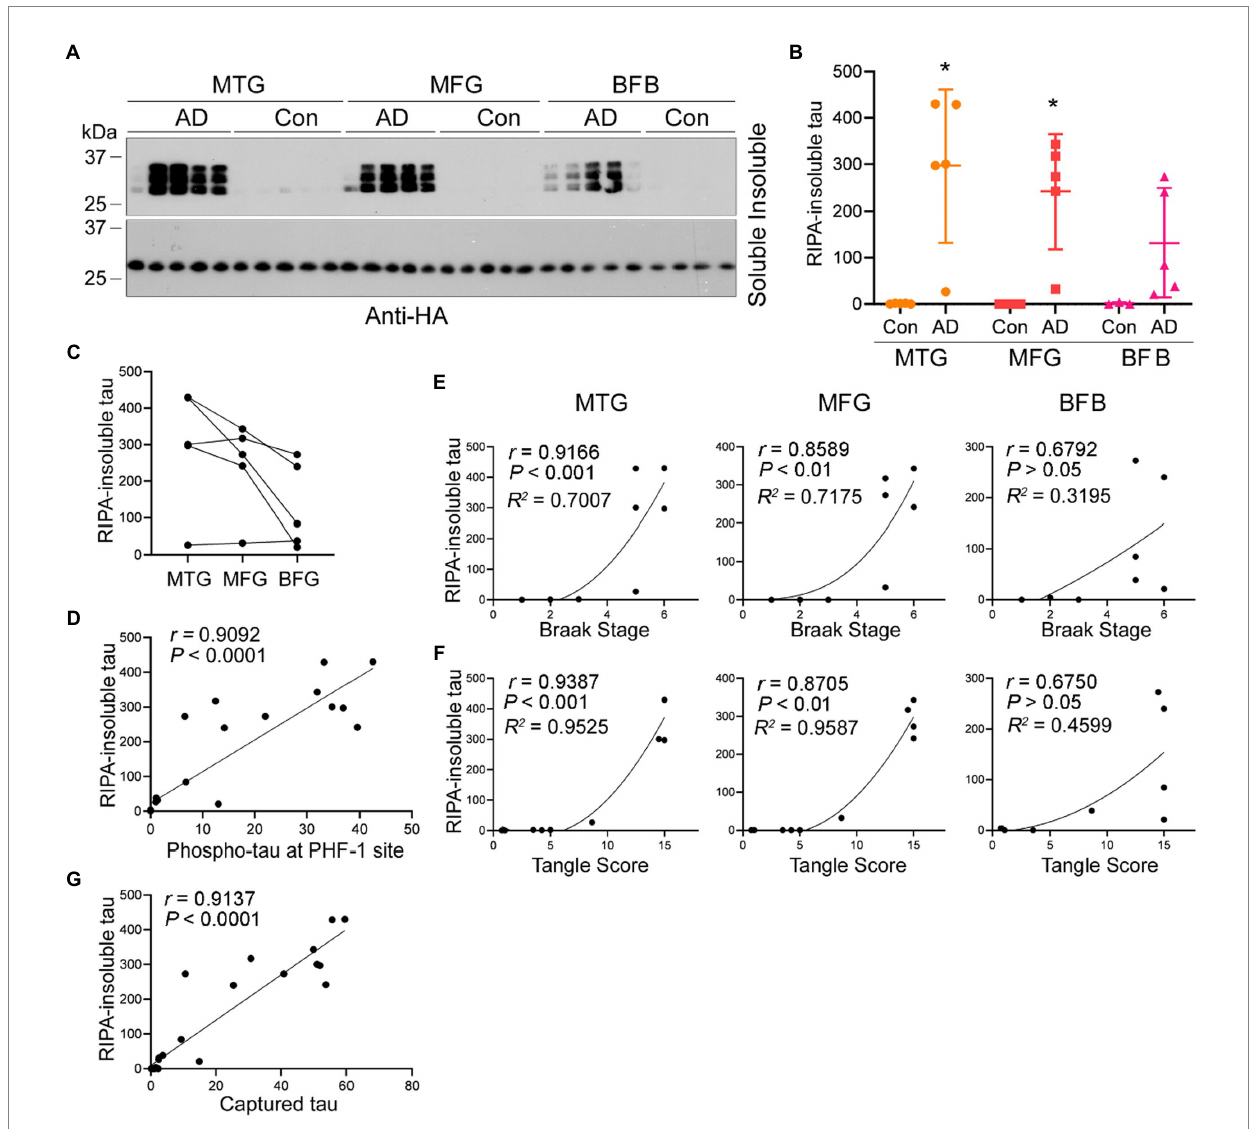
FIGURE 7 Association of increased seeding activity with tau pathology. (A–C) Tau seeding activity in AD brain assessed by the seeded tau aggregation assay. AD brain extracts seeded tau 151-391 aggregation in cultured cells. HEK-293FT/HA-tau 151-391 cells were treated with brain extract from three brain regions of AD and control cases for 42 h. RIPA-soluble and -insoluble taus were analyzed by Western blots (A) and are presented as scatter plots and mean ± SD (B) or across three brain regions of AD cases (C) . *, p < 0.05. (D) Tau seeding activity assessed by the seeded tau aggregation assay was positively correlated with phospho-tau levels in Figure 2C. The levels of RIPA-insoluble tau were plotted against the levels of phospho-tau. The correlation was analyzed by Pearson correlation analysis. (E,F) Tau seeding activity assessed by the seeded tau aggregation assay was positively correlated with Braak stage and tangle score. The levels of RIPA-insoluble tau induced by each region were plotted against the Braak stage (E) or tangle score (F) . The correlation was analyzed by Spearman correlation analysis and R 2 was calculated by non-linear regression. (G) Positive correlation of tau seeding activity assessed by two assays. Levels of seeded aggregated tau were plotted against the levels of captured tau. The correlation was analyzed by Pearson correlation